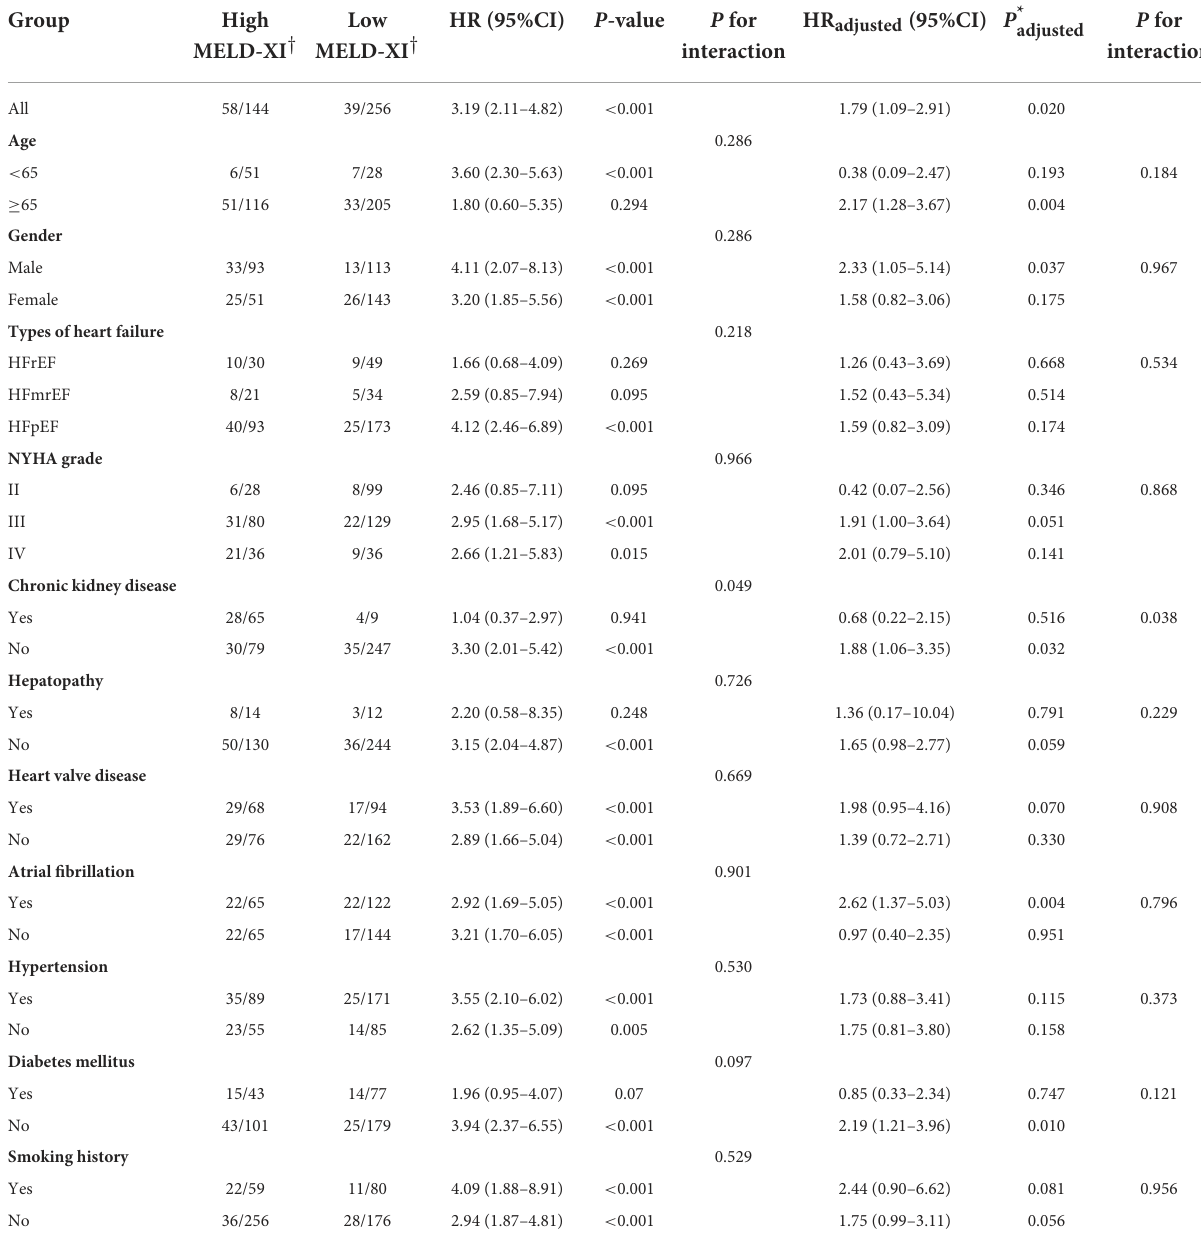
TABLE 4 The subgroup analyses of MELD-XI score and 3-year all-cause mortality of heart